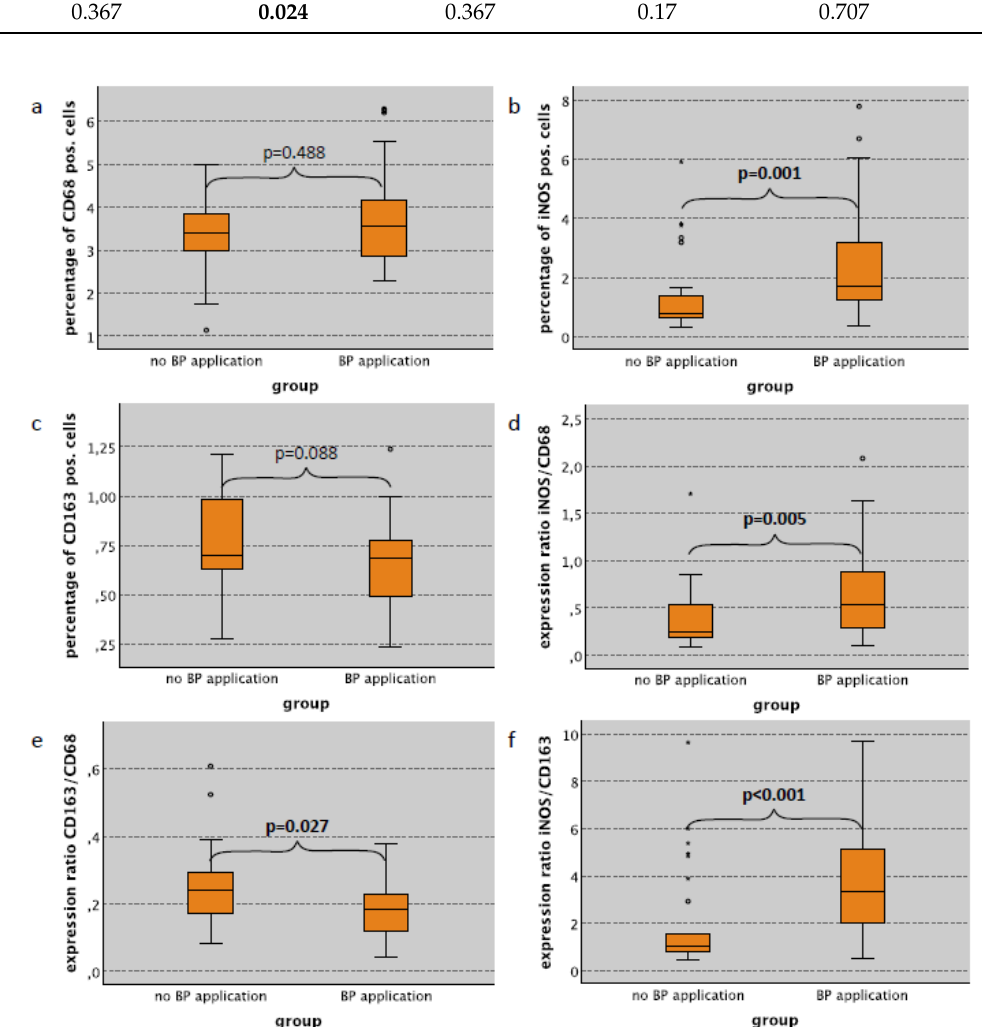
Figure 2. Influence of bisphosphonate application on macrophage infiltration and polarization in lung tissue without surgical trauma by analysis of the expression of different MP markers. ( a ) Percentage of CD68 pos. cells (pos. cells/all cells in %). ( b ) Percentage of iNOS pos. cells (pos. cells/all cells in %). ( c ) Percentage of CD163 pos. cells (pos. cells/all cells in %). ( d ) Expression ratio of iNOS and CD68 ((iNOS pos./all cells)/(CD68 pos./all cells)). ( e ) Expression ratio of CD163 and CD68 ((CD163 pos./all cells)/(CD68 pos./all cells)). ( f ) Expression ratio of iNOS and CD163 ((iNOS pos./all cells)/(CD163 pos./all cells)). Significant p -values ( p < 0.05) are indicated in bold letters. For statistical analysis, the Mann-Whitney-U-Test was used. * p < 0.05, ** p <